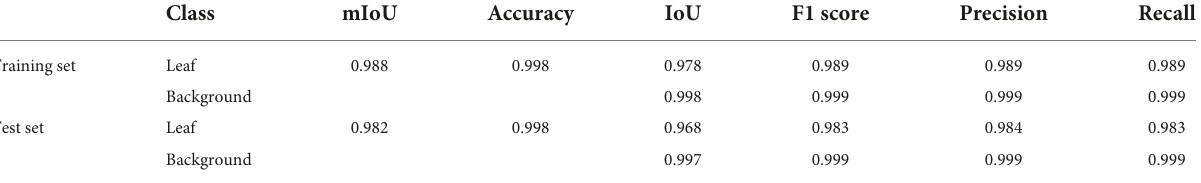
TABLE 3 Pixel-level accuracy indices of the leaf segmentation network. mIoU F1 score